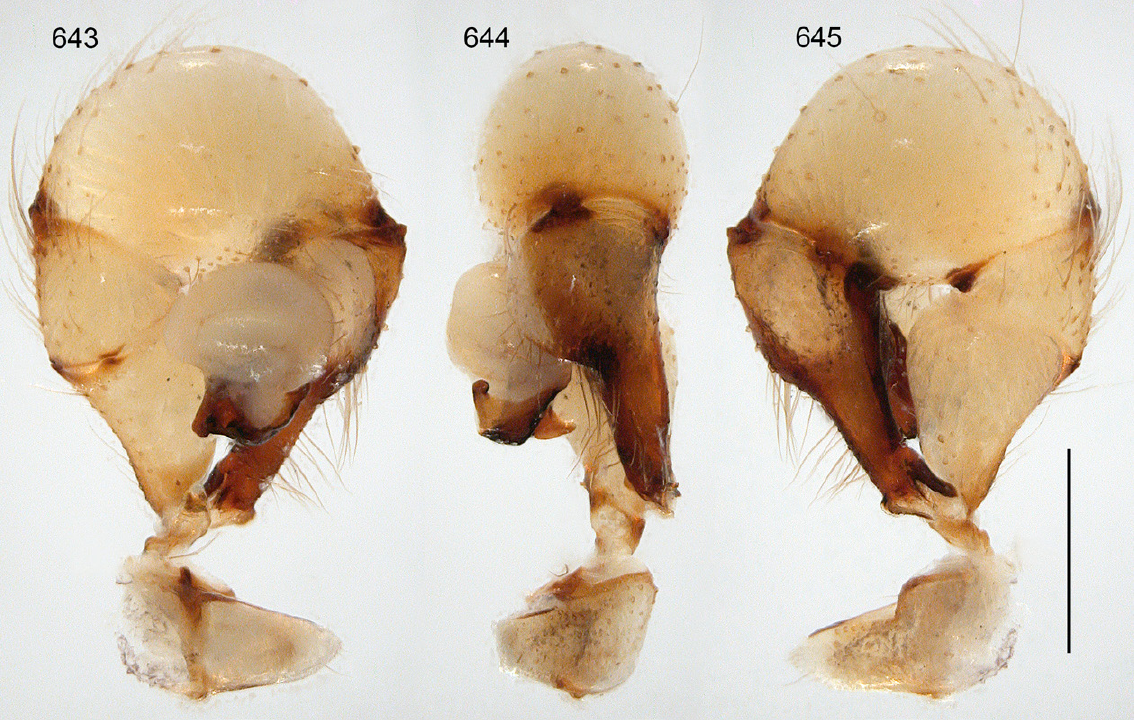
Figs 643–645. Crossopriza sanaa sp. nov.; non-type male from Yemen, near Sana’a (NMNL); left palp, prolateral, dorsal, and retrolateral views. Scale bar = 0.5